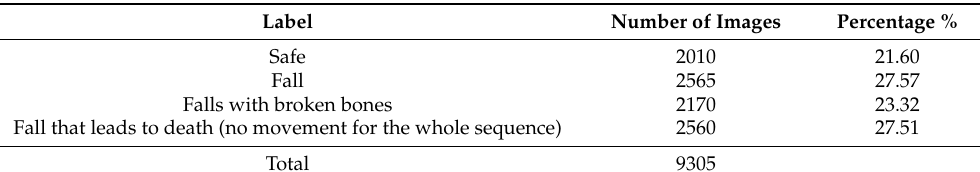
Table 1. Description of the datasets according to safe, fall, falls with broken bones, fall that leads to death cases in the SERV-112 dataset.